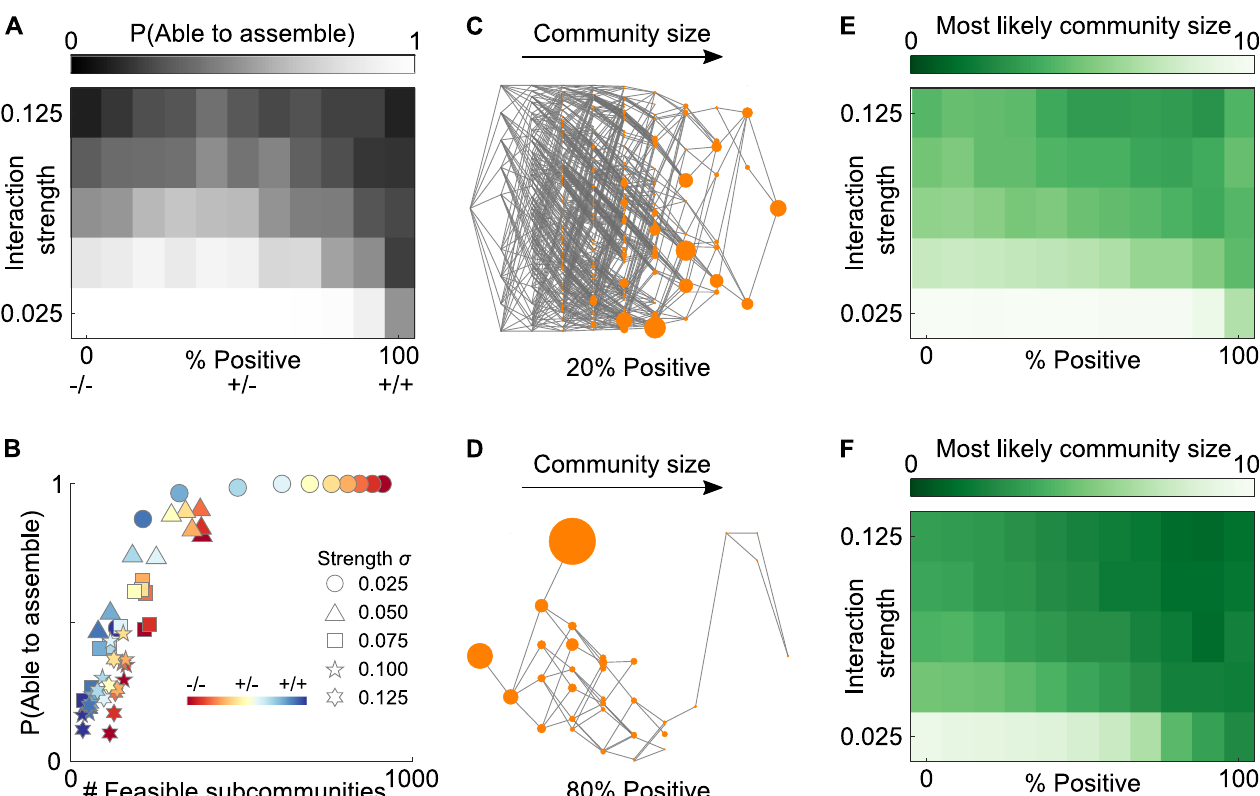
Fig 2. Strongly interdependent communities are harder to assemble. (A) Strong interactions (moving bottom to top) reduce the probability a community will be able to assemble via the random, sequential arrival of individual species. Symmetrical interactions ( − / − and +/+) are also more of a barrier to assembly than asymmetrical ones, with the most robust assembly seen in the middle of the figure (high number of +/ − interactions) moving left to right. ( B) A reduced ability to assemble stems from low numbers of feasible subcommunities, which lead to splits in the assembly map, such that there is no single path from uncolonized to fully colonized (Fig 1C). ( C, D) Treating the assembly map as a transition matrix allows us to calculate the probability of observing the community in a given state when subject to the continuous arrival and loss of taxa. In this illustration size of dot represents the probability of observing each subcommunity at any given time (here gamma / delta = 20). ( E, F) Heatmaps illustrate the most likely community size for communities that are capable of assembling when ( E ) the rate at which species arrive is much greater than the rate at which they are lost ( g = 20) or ( F ) when arrival and loss rates are similar ( g d d = 2). In each case, even when communities are capable of assembling from scratch, they will not necessarily be able to in the face of continuous arrival and loss of taxa. The more interdependent, or more strongly interacting species are, the less diverse the microbiota is likely to be at any given time. For all analyses, climax communities are drawn with S = 10, connectivity C = 0.5, from 150 independent replicates, underlying data in S1 and S2